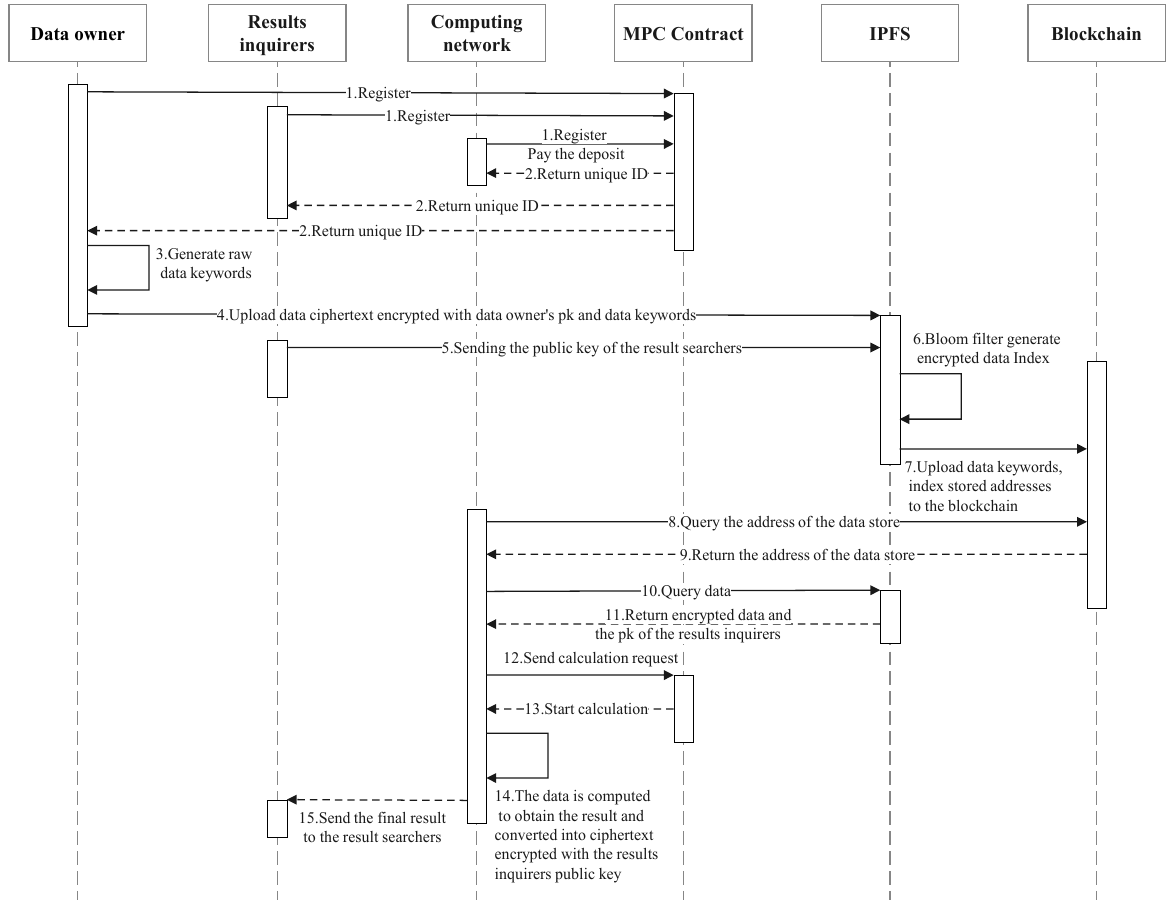
Figure 2. Timing diagram of system operation.